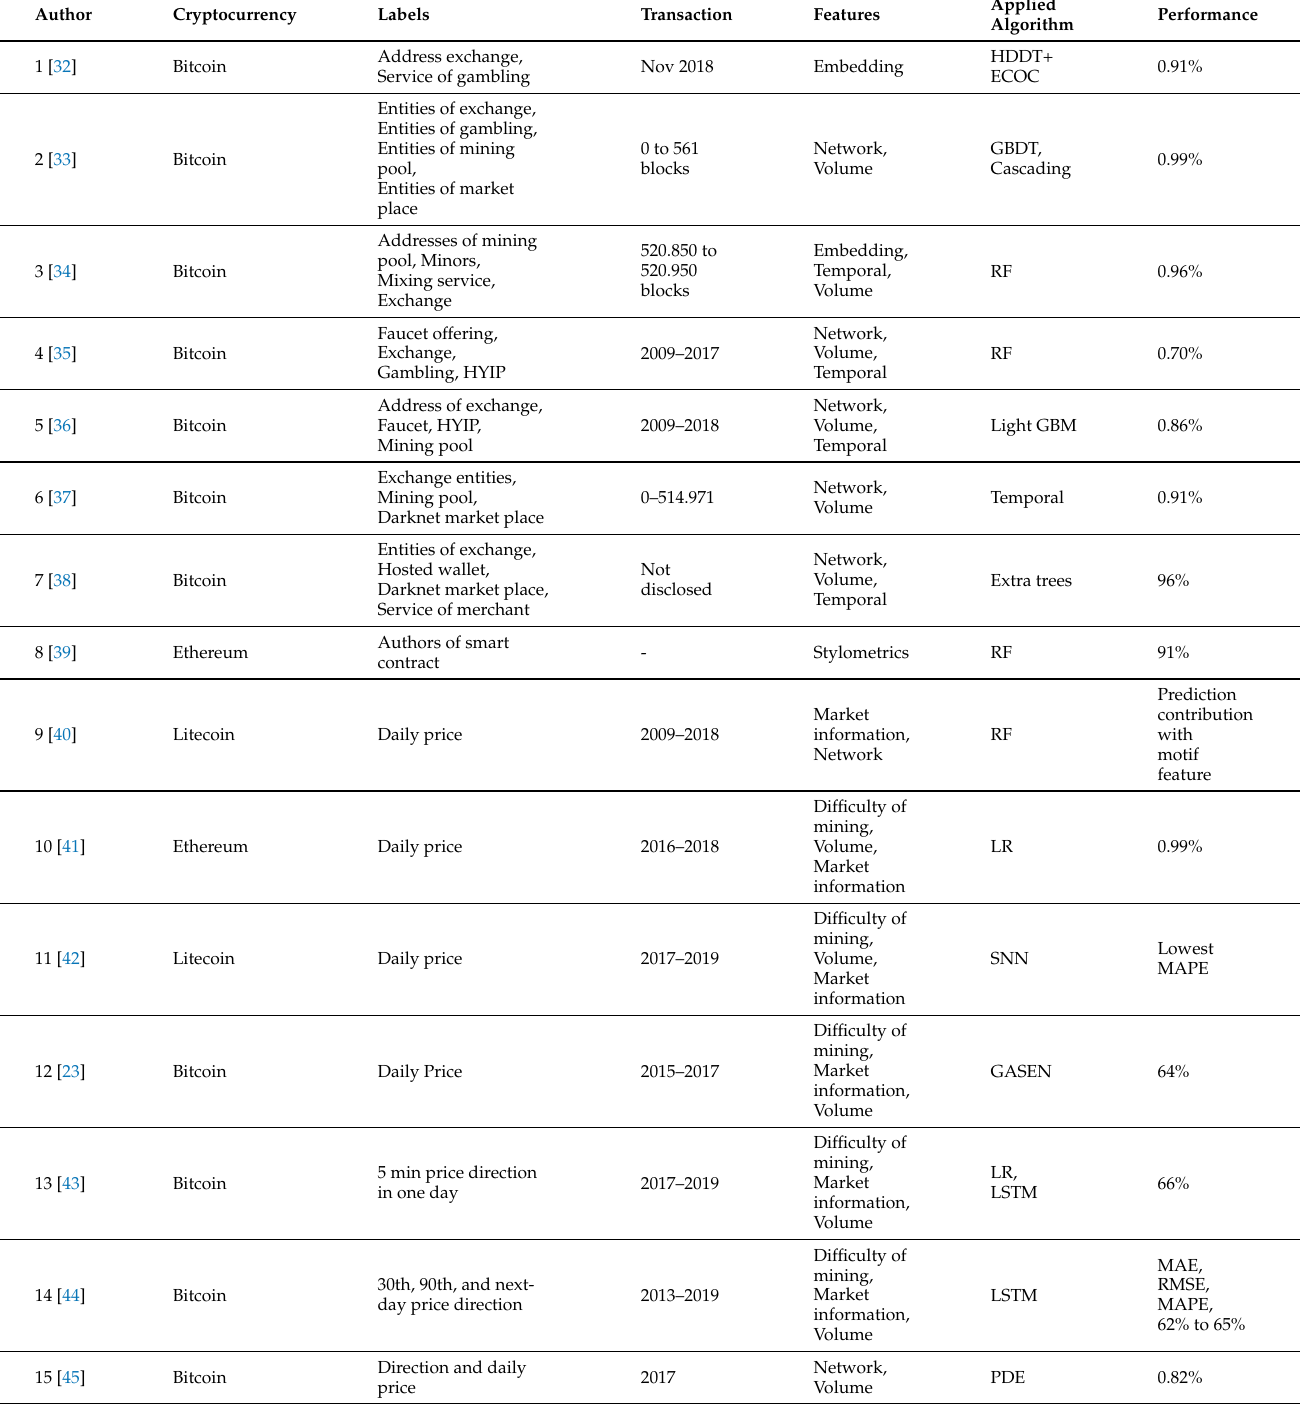
Table 1 presents the comparison of recent existing work on cryptocurrency price prediction. There are six categories for this Table: type of digital coin, labels, transaction, features, applied algorithm, and performance. Table 1. Comparison of recent price prediction tasks of